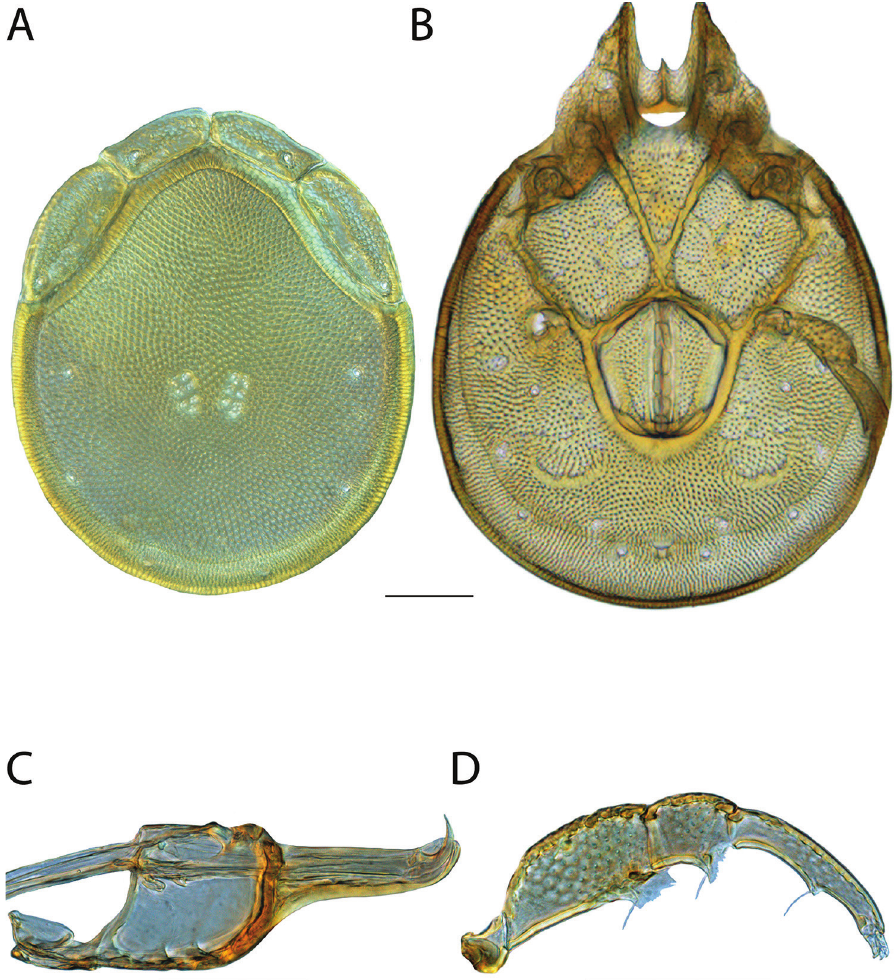
Figure 112. Torrenticola keesdavidsi female: A dorsal plates B venter (legs removed) C subcapitulum D pedipalp (setae not accurately depicted). Scale = 100